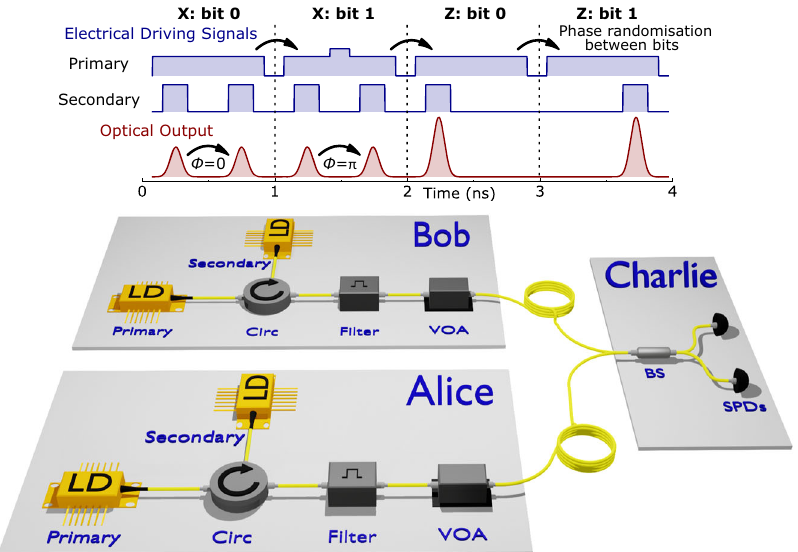
Fig. 1 MDI-QKD system experimental setup. LD laser diode, Circ circulator, VOA variable optical attenuator, BS beamsplitter, SPD single- photon detector. The inset illustration (top) shows the electrical signals applied to the lasers and the corresponding optical output for each basis/bit encoding.